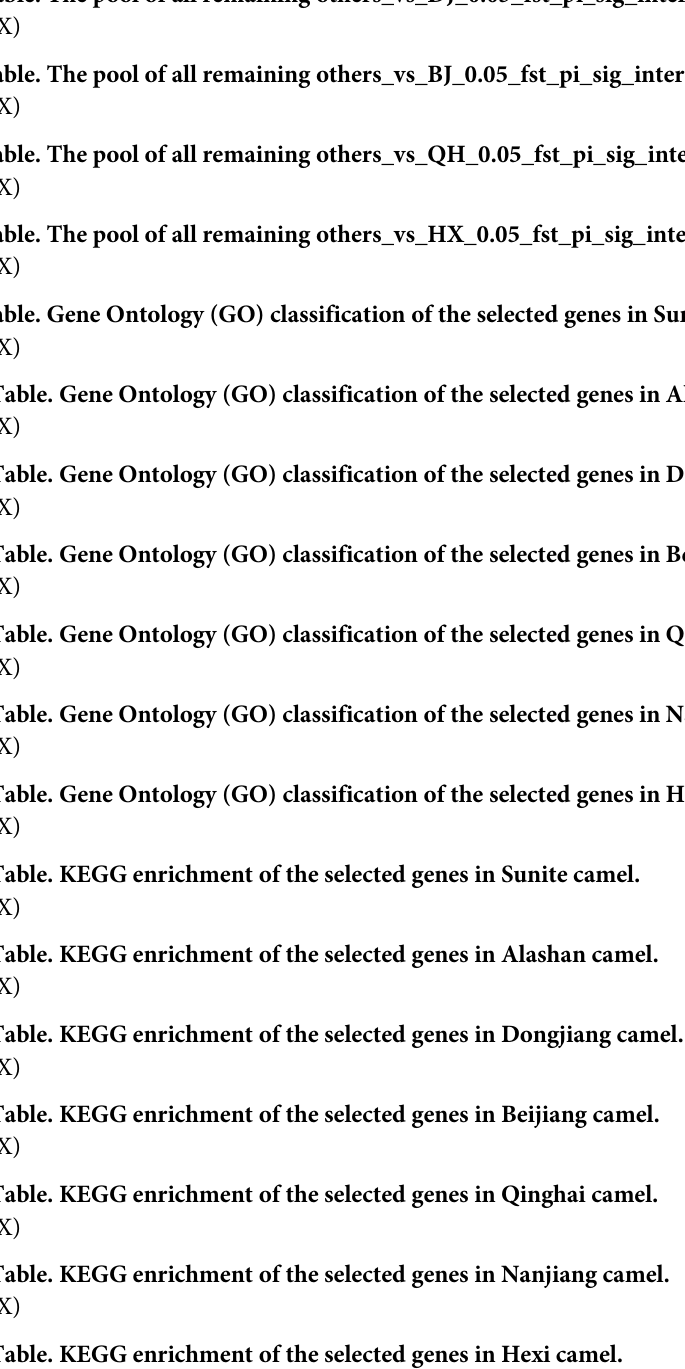
S10 Table. Gene Ontology (GO) classification of the selected genes in Alashan camel. S11 Table. Gene Ontology (GO) classification of the selected genes in Dongjiang camel. S12 Table. Gene Ontology (GO) classification of the selected genes in Beijiang camel. S13 Table. Gene Ontology (GO) classification of the selected genes in Qinghai camel. S14 Table. Gene Ontology (GO) classification of the selected genes in Nanjiang camel. S15 Table. Gene Ontology (GO) classification of the selected genes in Hexi camel. S16 Table. KEGG enrichment of the selected genes in Sunite camel. S17 Table. KEGG enrichment of the selected genes in Alashan camel. S18 Table. KEGG enrichment of the selected genes in Dongjiang camel. S19 Table. KEGG enrichment of the selected genes in Beijiang camel. S20 Table. KEGG enrichment of the selected genes in Qinghai camel. S21 Table. KEGG enrichment of the selected genes in Nanjiang camel. S22 Table. KEGG enrichment of the selected genes in Hexi